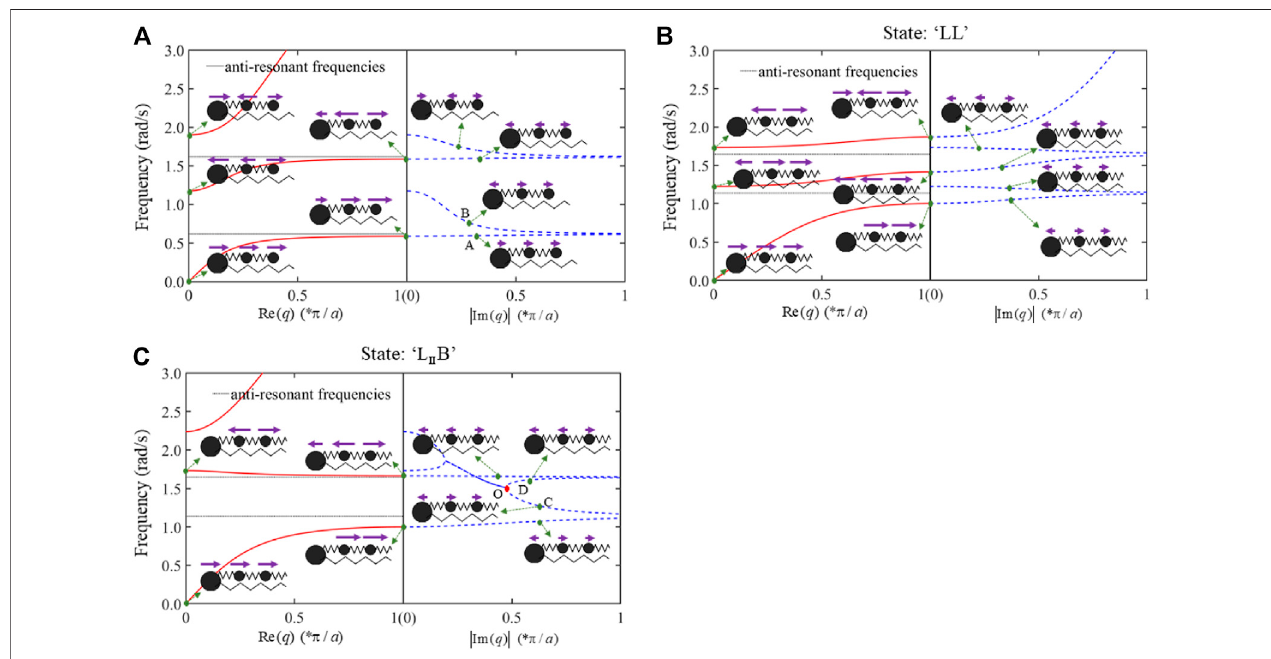
FIGURE 8 | Vibration modes of a unit cell at certain points in band structures for the (A) LR acoustic metamaterial with two resonators in series ( k 1 (cid:2) k 2 (cid:2) 1 , k 3 (cid:2) 0 , k (cid:2) 2 , M (cid:2) 0 . 5 , m 1 (cid:2) m 2 (cid:2) 1), (B) State “ LL ” ( k 1 (cid:2) k 2 (cid:2) k 3 (cid:2) 1 , k (cid:2) 2 , M (cid:2) 4 , m 1 (cid:2) m 2 (cid:2) 1), and (C) State “ L Ⅱ B ” ( k 1 (cid:2) k 2 (cid:2) k 3 (cid:2) 1 , k (cid:2) 2 , M (cid:2) 0 . 5 , m 1 (cid:2) m 2 (cid:2) 1). The purple arrows indicate the vibration directions and the lengths of the arrows represent the relative amplitudes. The corresponding amplitudes are zero when there are no arrows above the